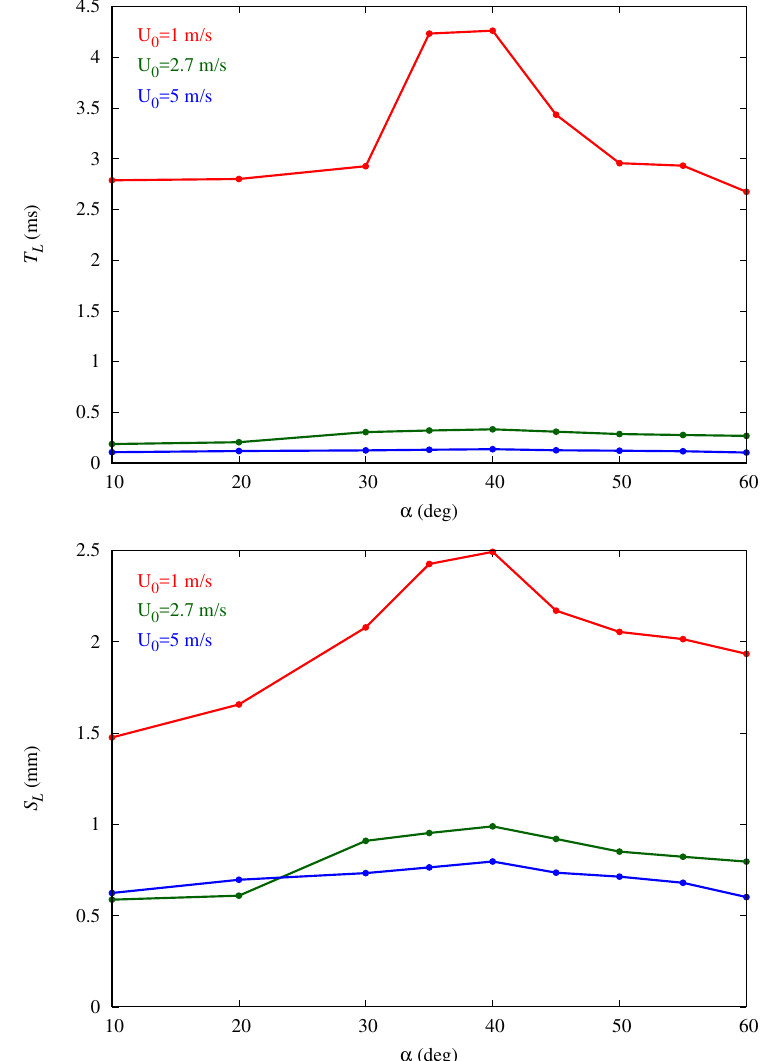
Figure 8. Plots of average droplet residence time (top panel) and arc length (bottom panel) for varying body inclination angles (runs A2–A10). Higher residence times are associated with higher arc lengths and higher probability for droplet capture by the